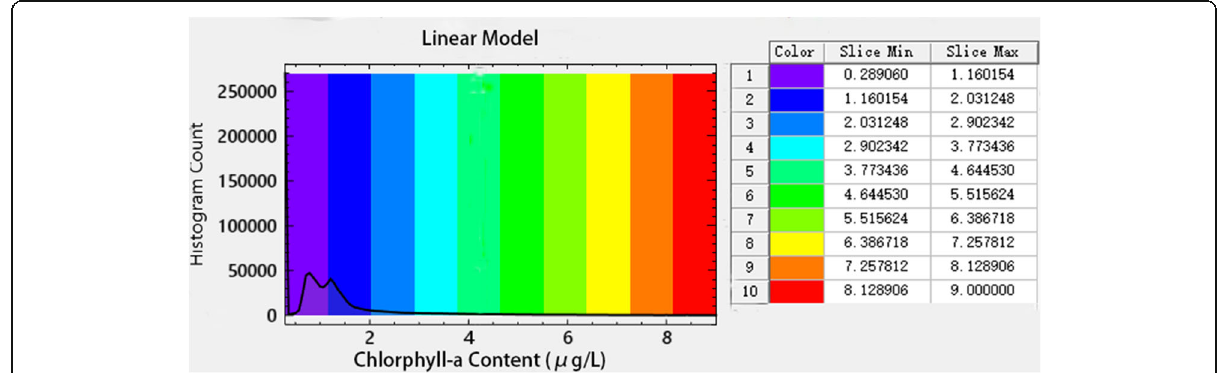
Fig. 12 The distribution of chlorophyll-a concentration in logarithmic